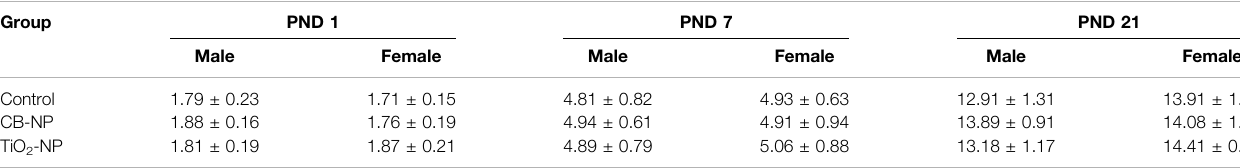
TABLE 3 | Body weight (g) of offspring at postnatal days (PND) 1, 7, and 21.